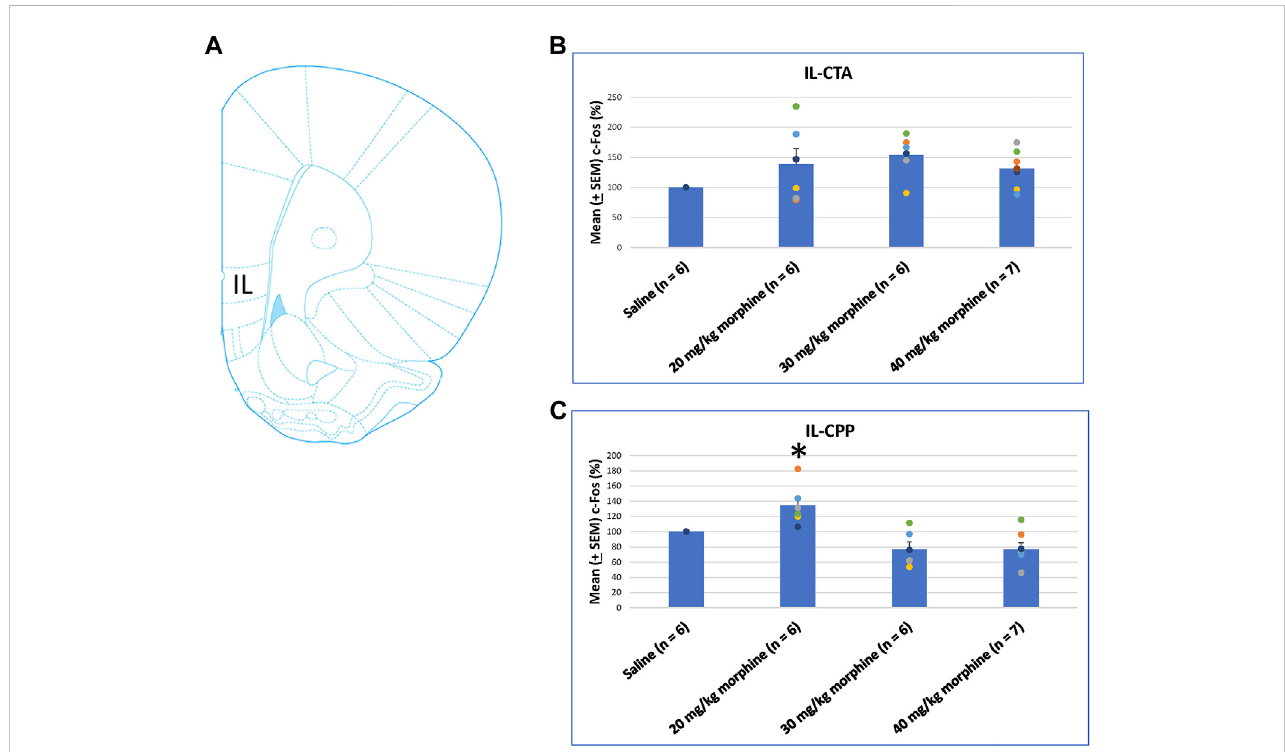
FIGURE 8 (A) Representative image of c-Fos immunoreactivity in the infralimbic cortex (IL). Mean (±SEM) c-Fos (%) in the IL in the following (B) CTA and (C) CPP tests.Non-signi fi cantdifferencesoccurredwhencomparingthesalineforCTAandCPP(both, n =6)orwithmorphineindosesof20 mg/kgforCTAandCPP (both, n = 6), 30 mg/kg for CTA and CPP (both, n = 6), and 40 mg/kg for CTA ( n = 6) and CPP ( n =